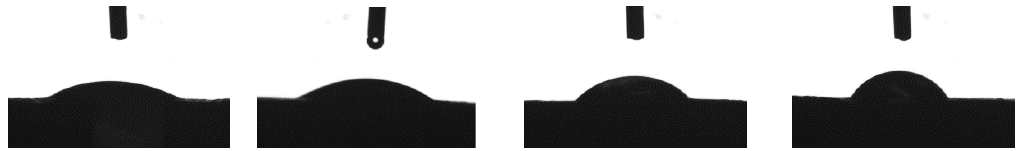
Figure 12. Illustrative microphotographs taken during the contact angle measurement. From the